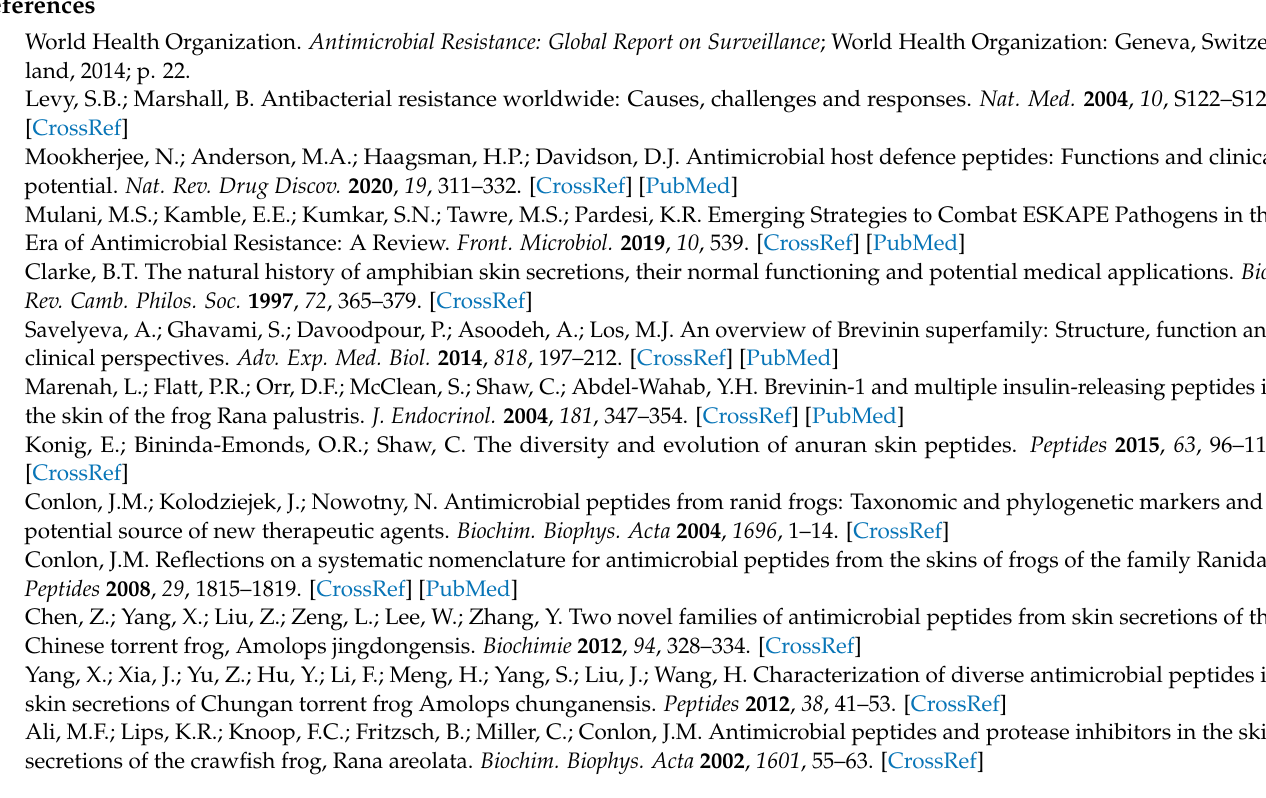
the hydrophobic moments; Figure S3: RP–HPLC chromatograph of GL-29 and its analogues at a wavelength of 214nm and the arrow indicates the retention times/elution position of the peptide; Figure S4: MALDI-TOF mass spectrum of GL-29 and its analogues; Table S1: Secondary structure analysis of GL-22 truncated analogues in different